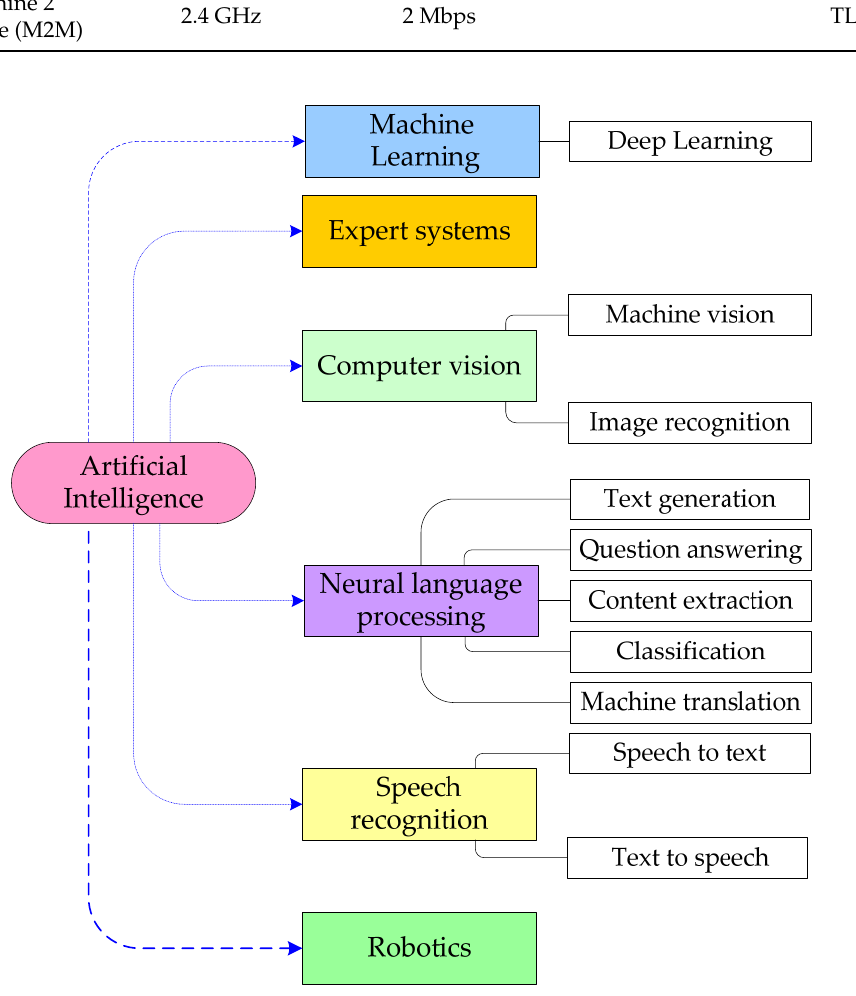
Figure 6. Subsets of AI.